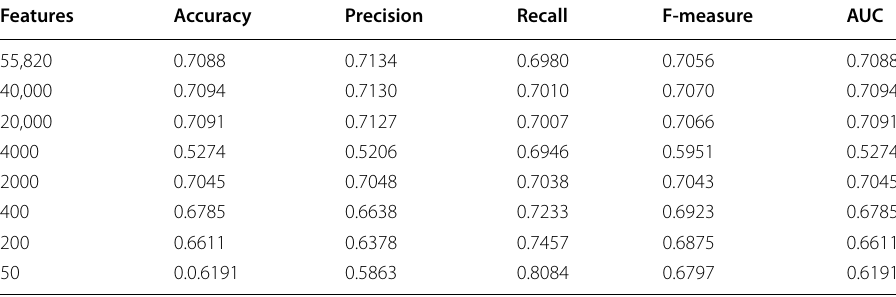
Table 3 Performance of the ANOVA F-test feature selection on the StockTwits dataset